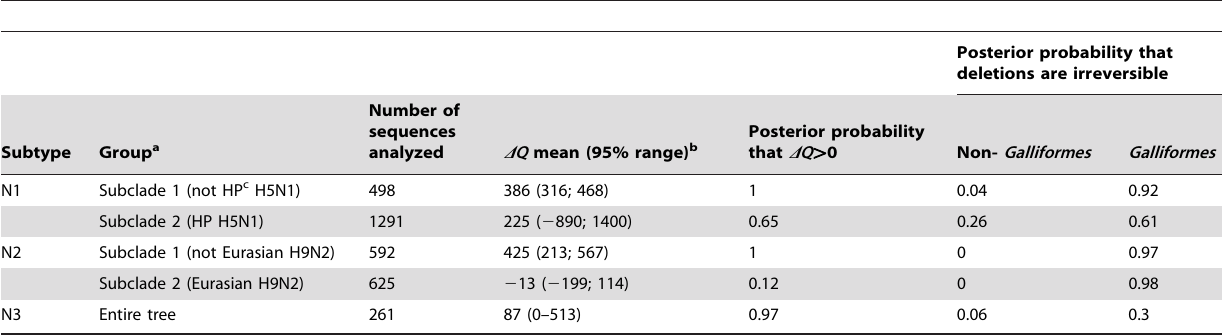
Posterior probability that deletions are irreversible